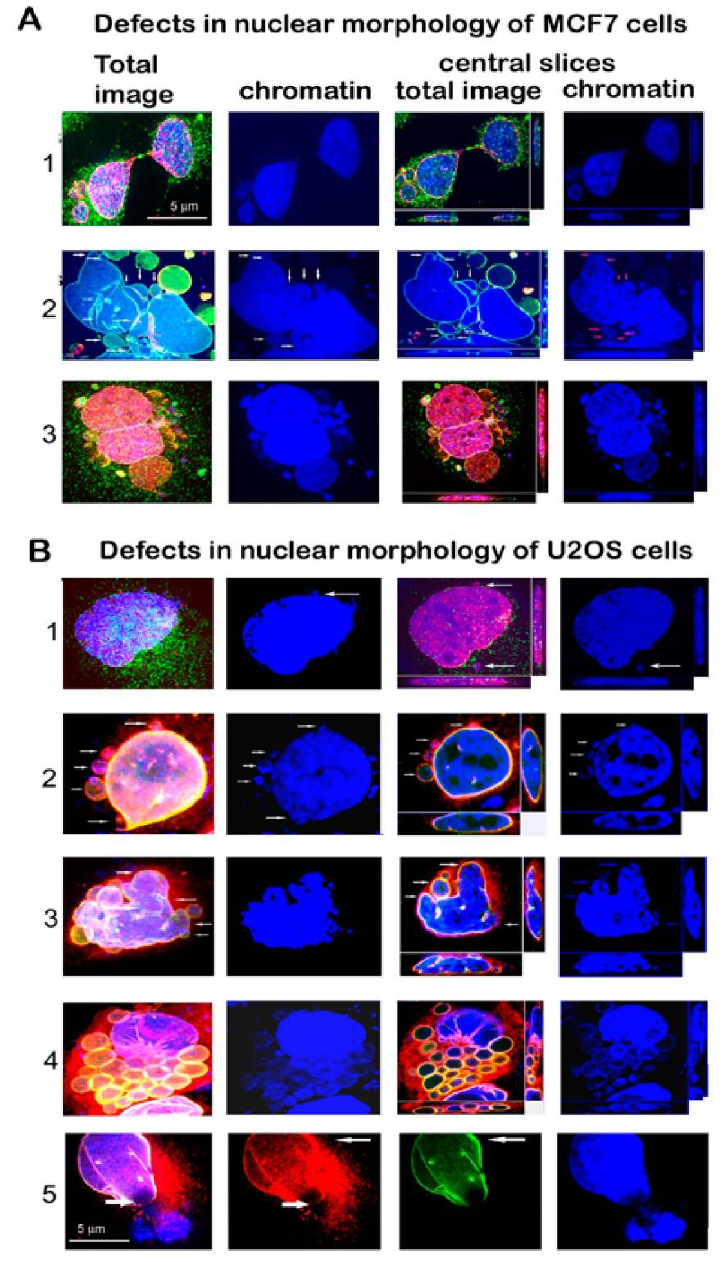
Figure 3. Examples of nuclear morphology defects in ( A ) MCF7 and ( B ) U2OS cell lines 24 h PI with the dose of 8 Gy of γ-rays. ( A ) 1—An anaphase bridge linking the separating daughter nuclei, SUN1 (red), nesprin1 (green), 2—Convoluted nucleus with blisters (arrows), LA/C (green), emerin (red). 3—Fragmented nucleus represented by 3 large and numerous small micronuclei. SUN2 (red), nesprin-1 (green). ( B ) 1— A giant nucleus with small chromatin fragments and micronuclei (MN, arrows), SUN1 (red), nesprin-1 (green). 2—Nucleus with micronuclei, emerin (red), lamin A/C (green), arrows indicate MN containing emerin and heterochromatin (HC), 3—Convoluted nucleus with blisters (arrows), emerin (red), LA/C (green). 4—Fragmented nucleus, emerin (red), LA/C (green). 5—Honeycombed nucleus, emerin (red), LA/C (green), thick arrow shows interrupted NE enabling chromatin to leak out of the nucleus, reinforced layer of LA/C (green) and emerin (red), (thin arrows). Size bar indicates µm.